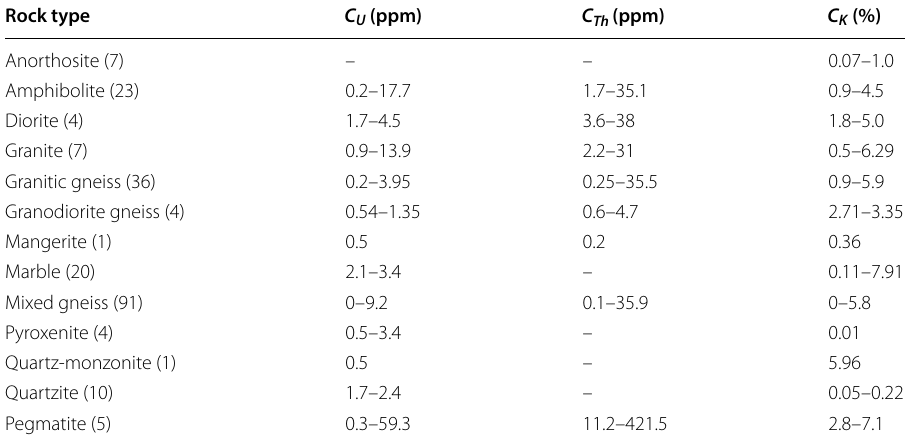
Table 4 Concentration of radiogenic elements for outcropping rocks of the Morin Terrane (including samples from outside our study area)